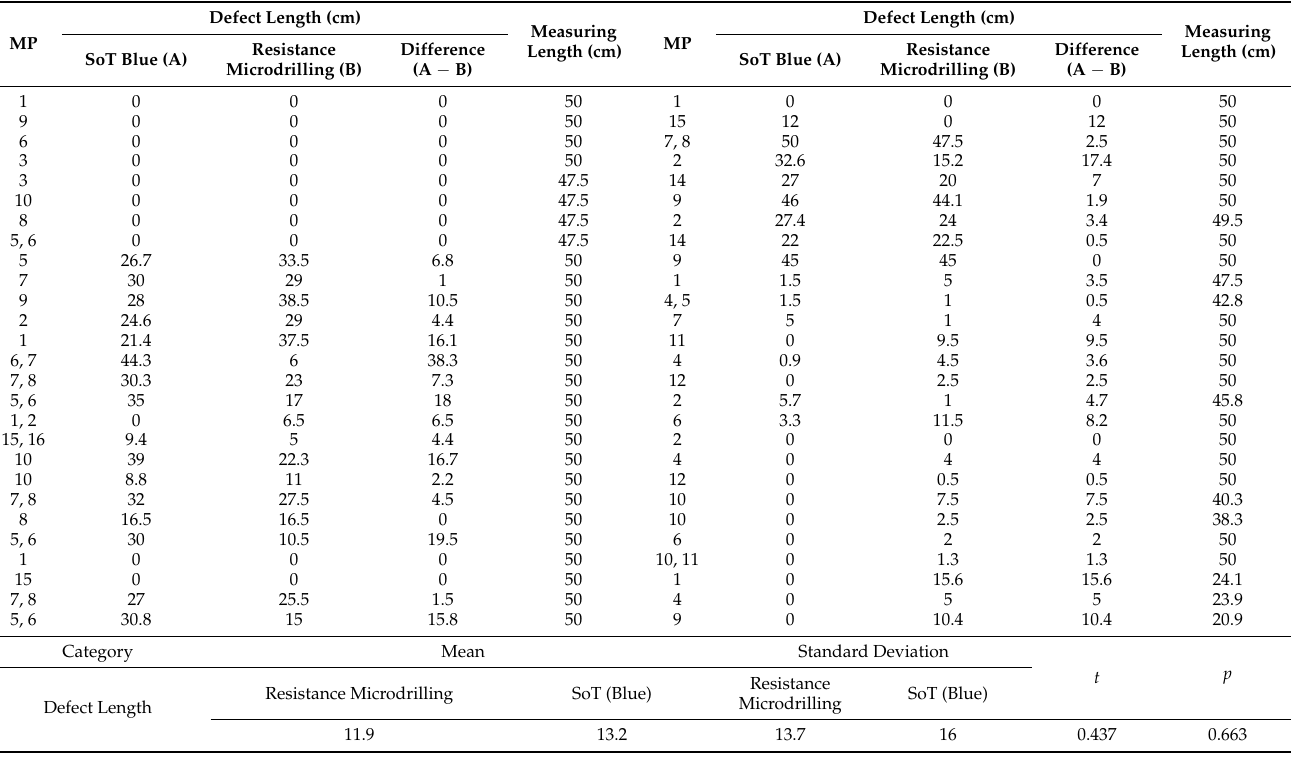
Table 1. Results of t -test on lengths of defects measured with sonic tomography (SoT) and resistance microdrilling ( N = 54). MP: measuring point; SoT blue: blue and red color in the SoT tomograms.